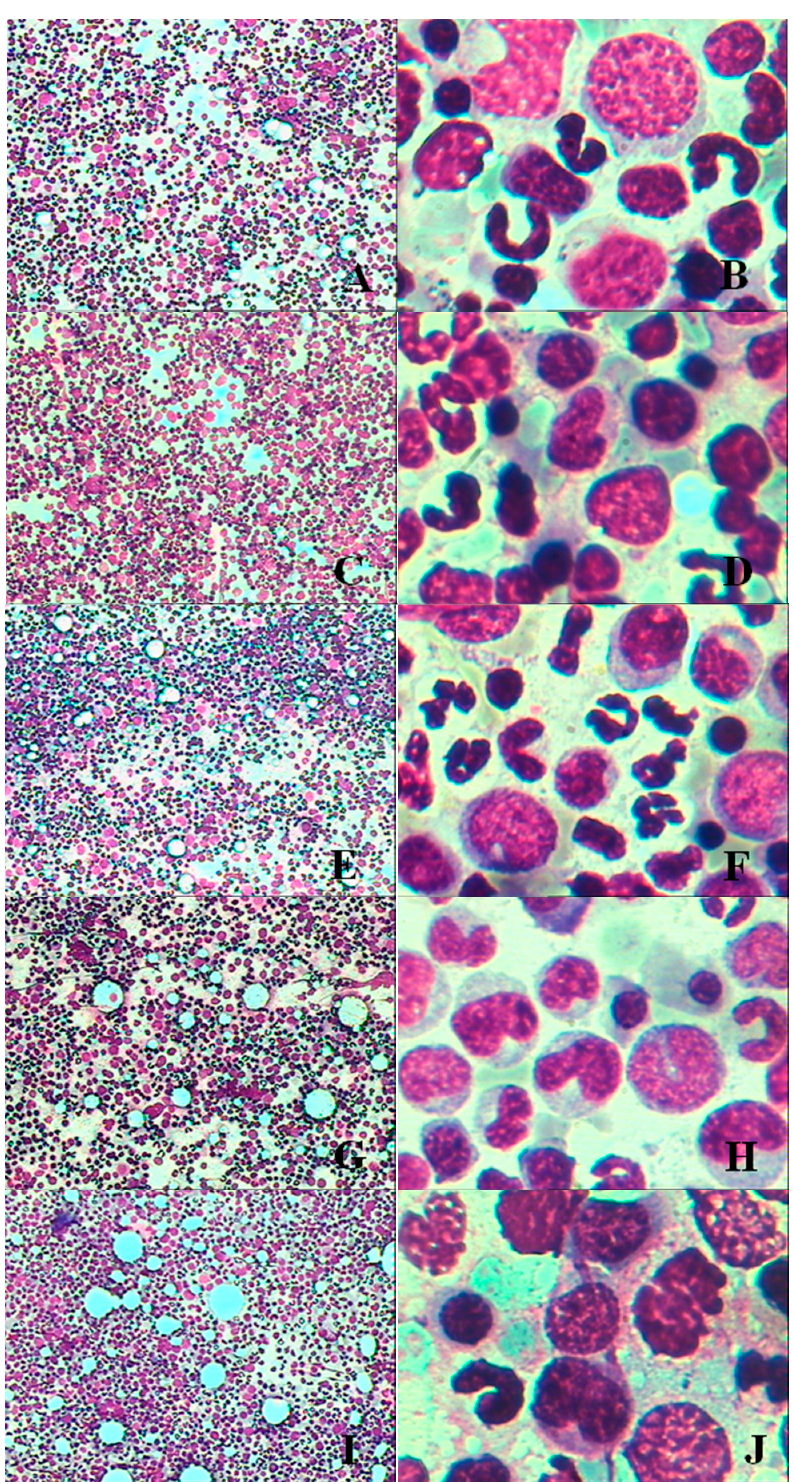
Figure 2. Bone marrow of dogs after treatments of HZ1006 ( A – J ) ( A , C , E , G , I : original magnification × 100; B , D , F , H , J : original magnification × 1000). ( A ) photomicrograph of bone marrow from ♂ 29 (control group) on d28, original magnification × 100; ( B ) bone marrow from ♂ 29 (control group) on d28, original magnification × 1000; ( C ) bone marrow from ♀ 4 (5-mg/kg dose group) on d28, original magnification × 100; ( D ) bone marrow from ♀ 4 (5-mg/kg dose group) on d28, original magnification × 1000; ( E ) bone marrow from ♀ 22 (20-mg/kg dose group) on d28, original magnification × 100; ( F ) bone marrow from ♀ 22 (20-mg/kg dose group) on d28, original magnification × 1000; ( G ) bone marrow